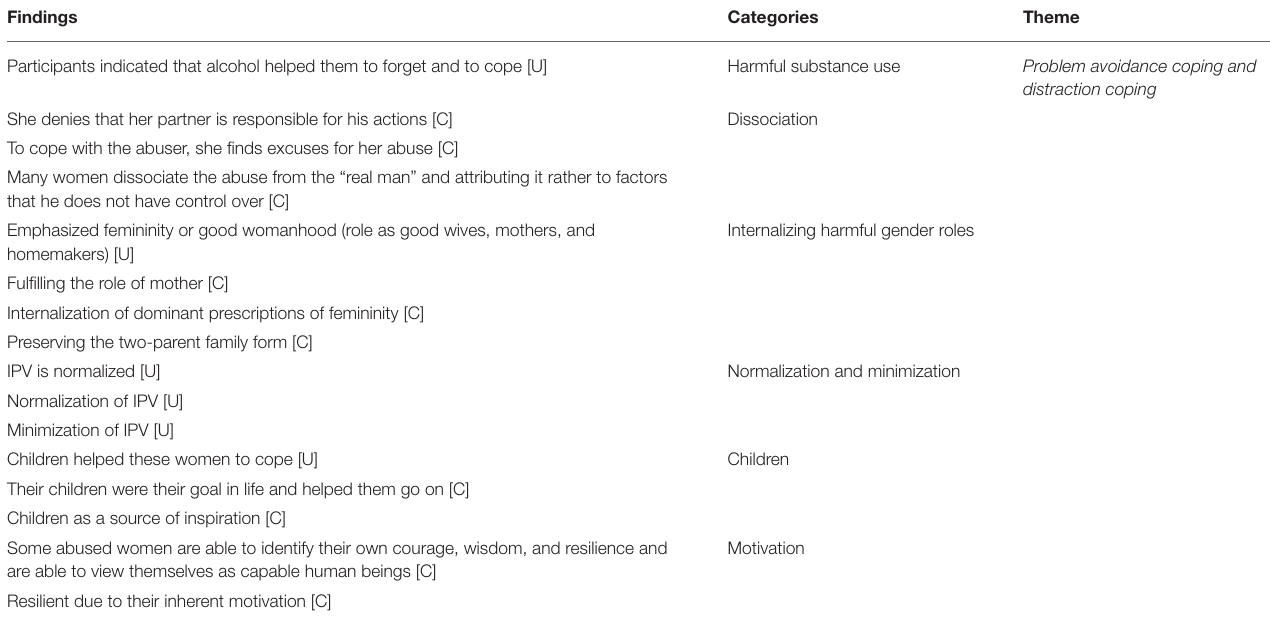
TABLE 6 | Theme 3: Problem avoidance coping and distraction coping.